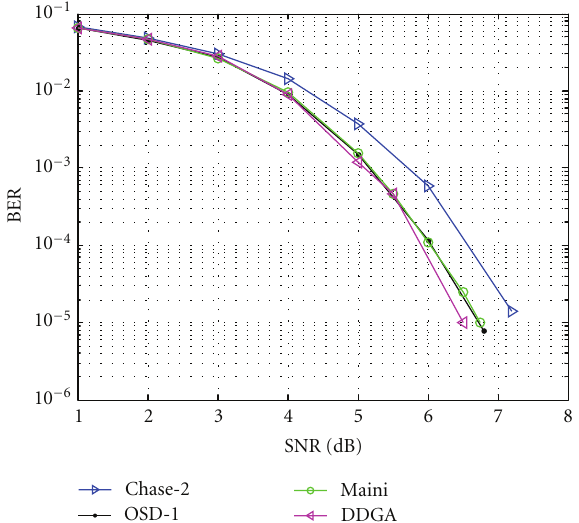
Figure 19: Performances of Chase-2, OSD-1, Maini, and DDGA algorithms for BCH (127,120,3) code.